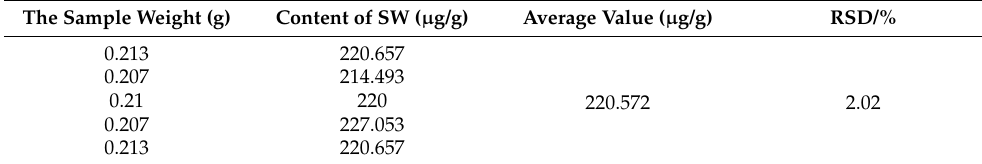
Table 5. Process validation test results.